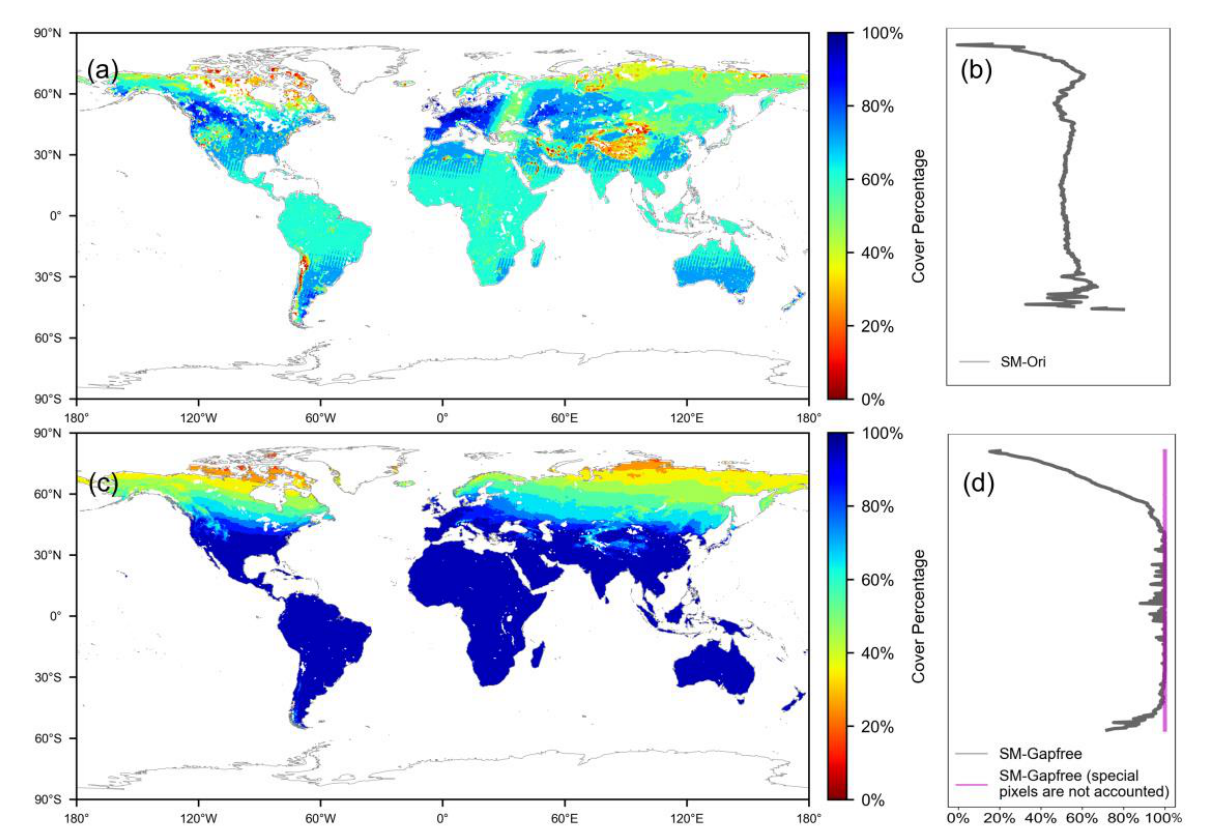
Figure 5. Fraction of valid observations in the NN-SM product ( a ) and reconstructed gap-free product ( c ) in 2002–2020 (with daily step), and latitudinal plots of valid observations percentage of the NN-SM product ( b ) and reconstructed gap-free product ( d ). Reconstructed gap-free product, in black line; reconstructed gap-free product if the special pixels (i.e., permanent snow/ice, frozen soil and water) are not accounted, in magenta line. Note: water and snow/ice covered areas are masked out and displayed in white color.